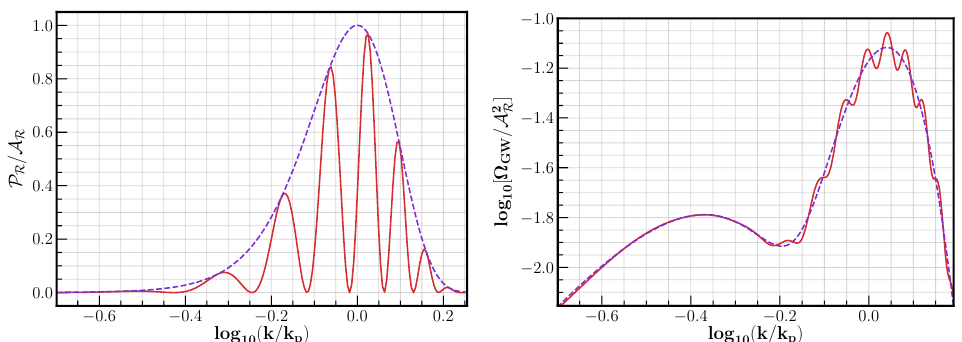
Figure 7. Primordial spectrum and induced GWs from a sharp turn in the inflationary trajectory from the model of Ref. [84], courtesy of L. Witkowski, J. Fumagalli and S. Renaux-Petel. Left: Normalized primordial spectrum in terms of wavenumber k / k p . The solid line is the power spectrum resulting from the sharp feature. The dashed line is the envelope of the oscillations. They are respectively given = 20. Right: Induced GW spectral density by Equations (25) and (26) of Ref. [84] with δ = 0.5 and η ⊥ normalized by . The solid line is the induced GW spectrum of the oscillatory power spectrum A R while the dashed line is the induced GWs from the envelope properly normalised. The oscillations have an amplitude of about 20% larger than the envelope around the induced GW spectrum